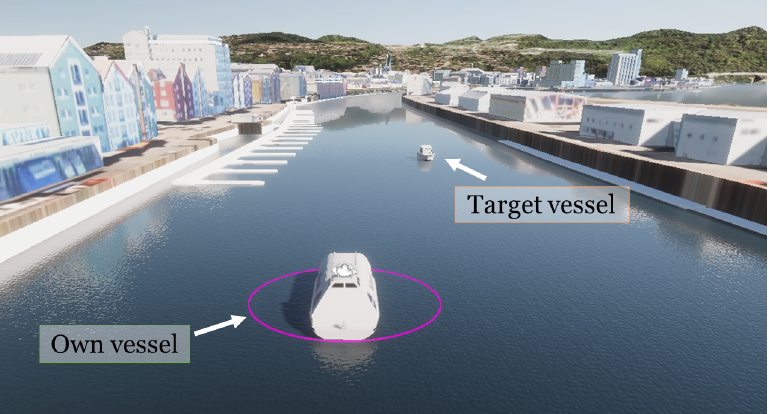
Figure 5. The own vessel navigates in a head-on encounter situation with another target vessel in the Trondheim channel. Screenshot from the Autoferry Gemini